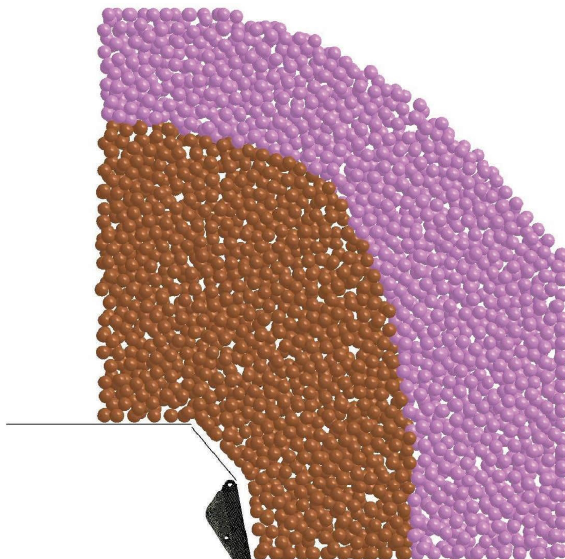
Figure 4: Te coal gangue boundary in the numerical model.